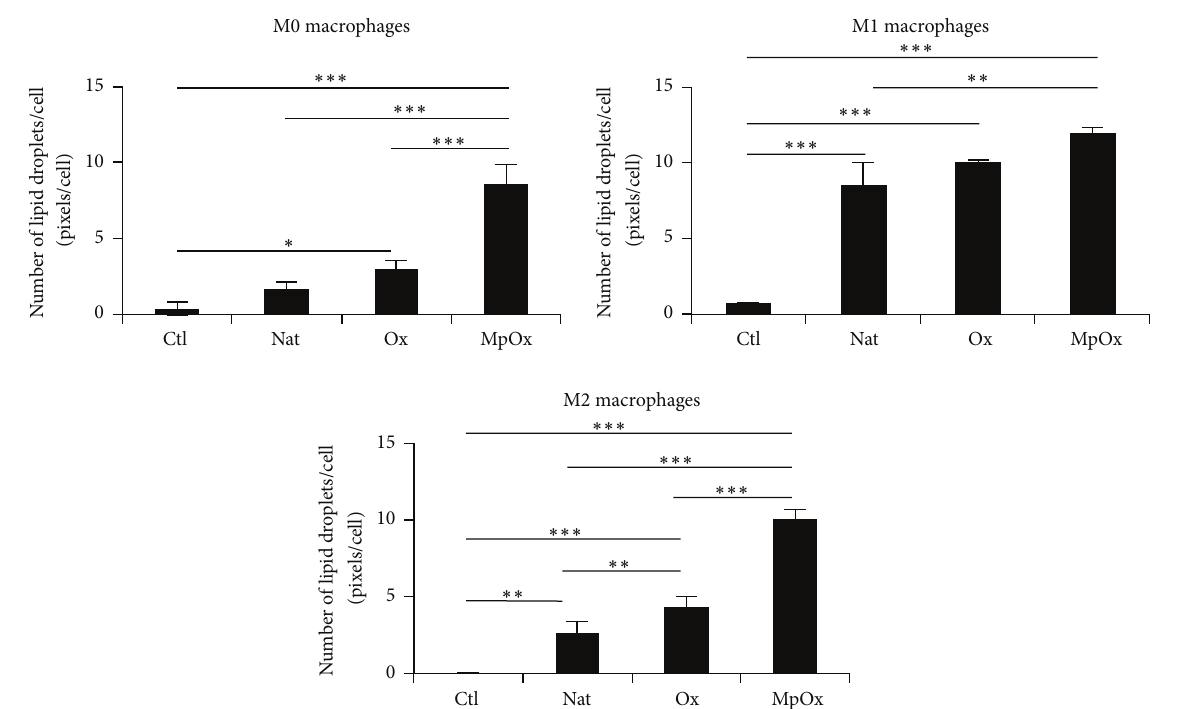
Figure 6: Comparative effects of LDLs on (un)polarized RAW 264.7 macrophages to induce foam cells. M0, M1, and M2 macrophages were incubated in the presence or absence of Nat-LDLs, Ox-LDLs, and MpOx-LDLs (100 𝜇 g/mL) for 24 hours. The number of lipid droplets was estimated using a High Content Imager, as described in Materials and Methods. Data are expressed as mean ± SD ( 𝑛 = 3 ). ANOVA 1: ∗ 𝑝 < 0.05 ; ∗∗ 𝑝 < 0.01 ; and ∗∗∗ 𝑝 < 0.001